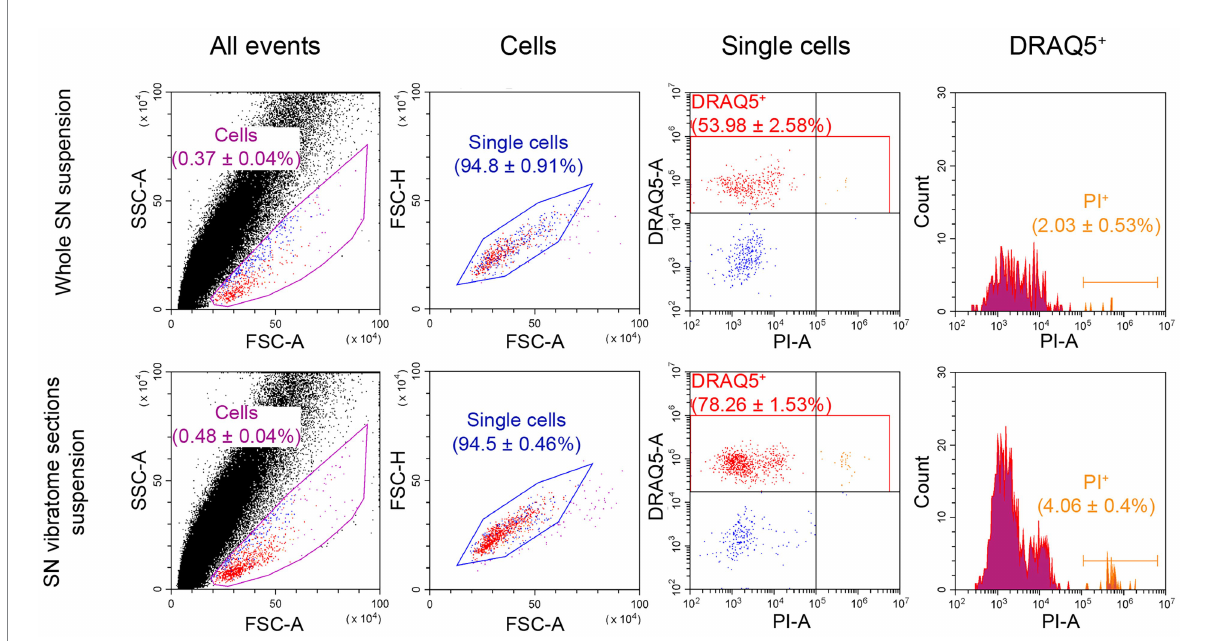
FIGURE 4 Flow cytometry analysis of cell viability as a relation of dead cells (propidium iodide (PI)-stained) to DRAQ5-stained cells. For each measurement n = 3. FSC, forward scatter; SSC, side